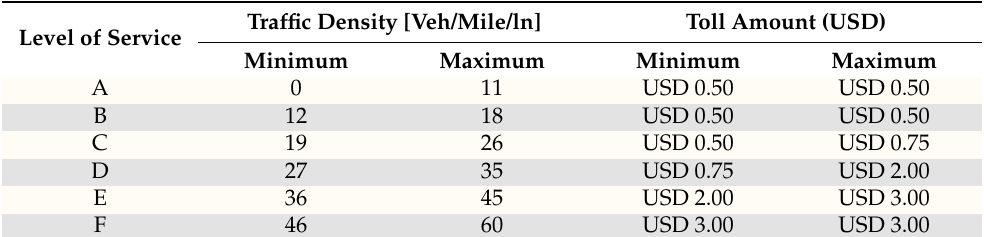
Table 7. Level of service and toll amount for the Northbound